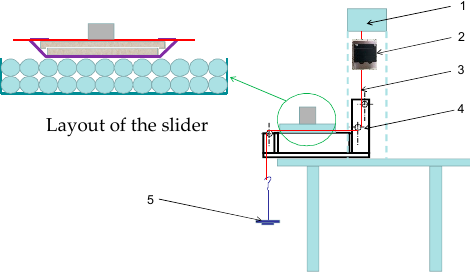
Figure 4. Schematic diagram of the test of sliding friction coefficient.